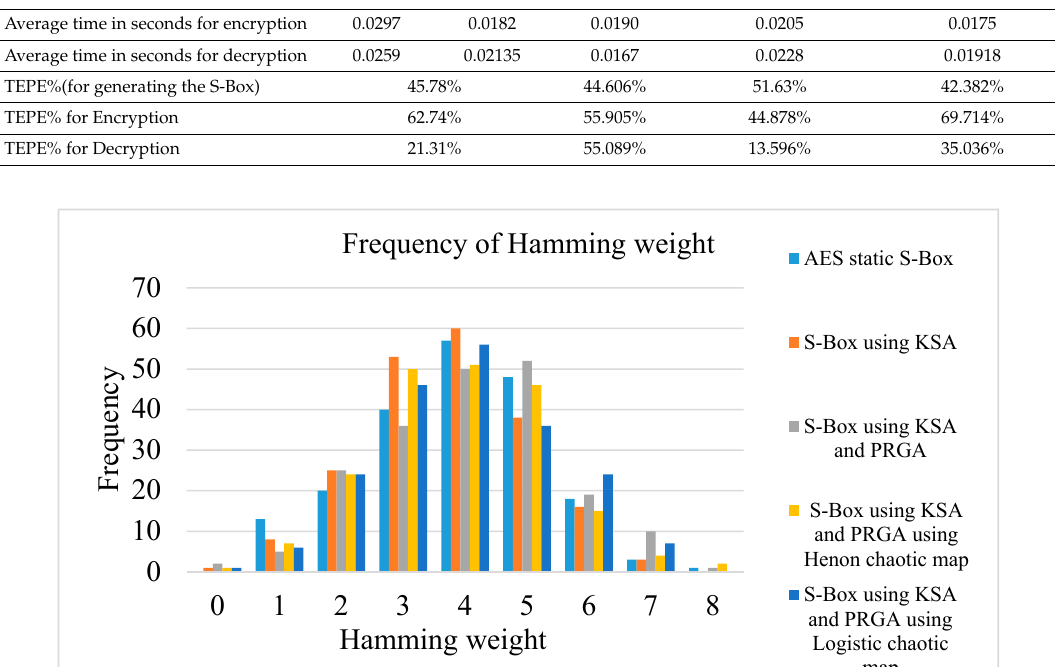
Figure 11. Hamming weights: a comparison between the five S-Boxes with the key “F9E8D7C6B5A40123”.